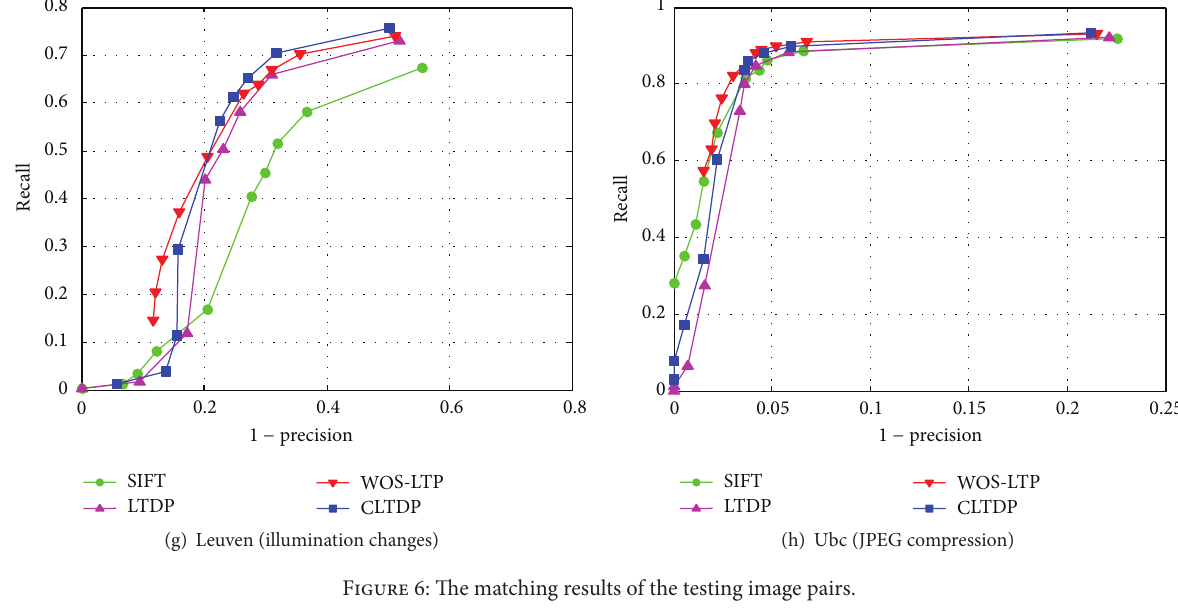
Figure 6: The matching results of the testing image pairs.